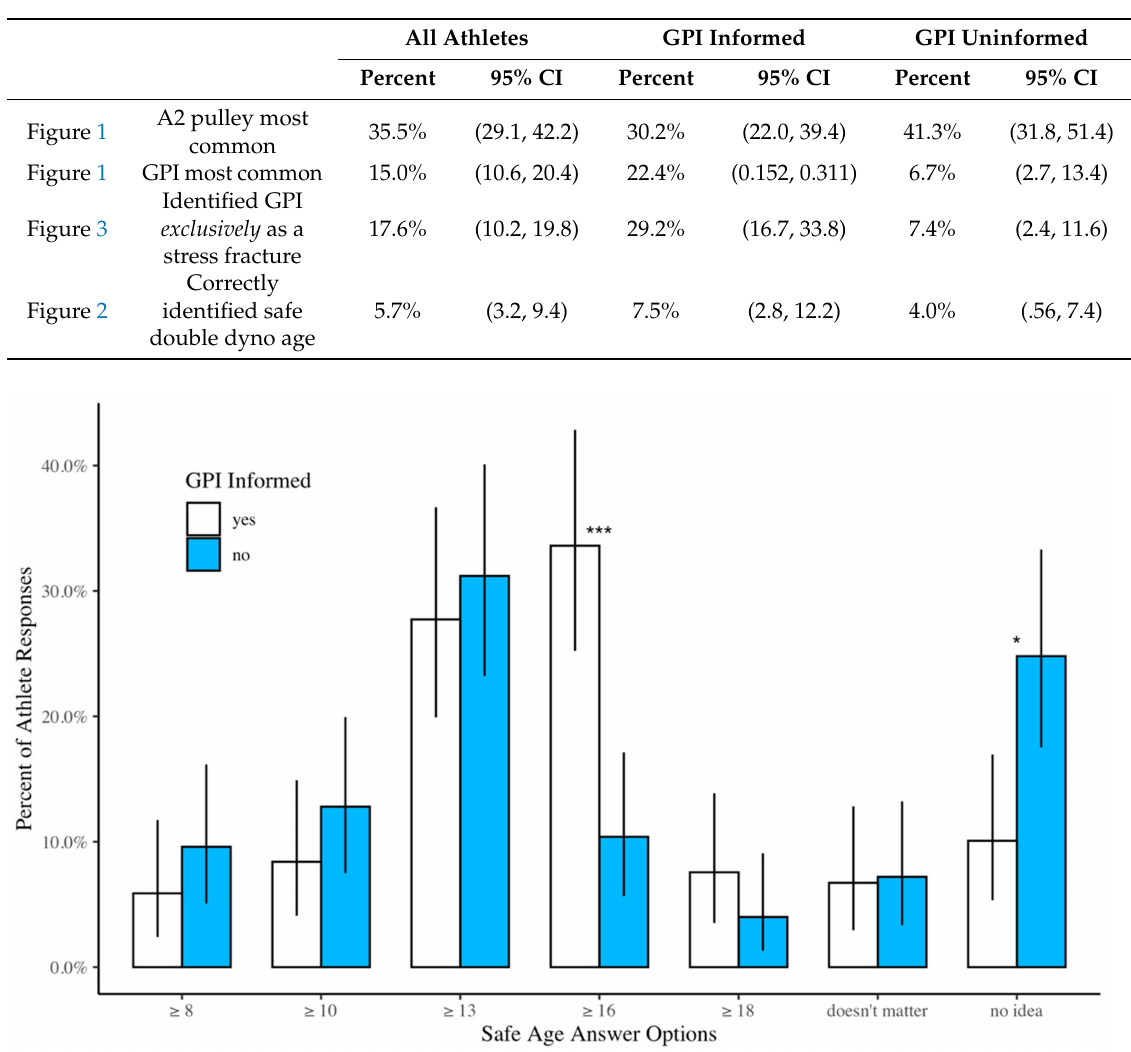
Table 2. Percent and 95% CI of athlete responses for all athletes, growth plate injury (GPI) informed, and growth plate injury (GPI) uninformed.